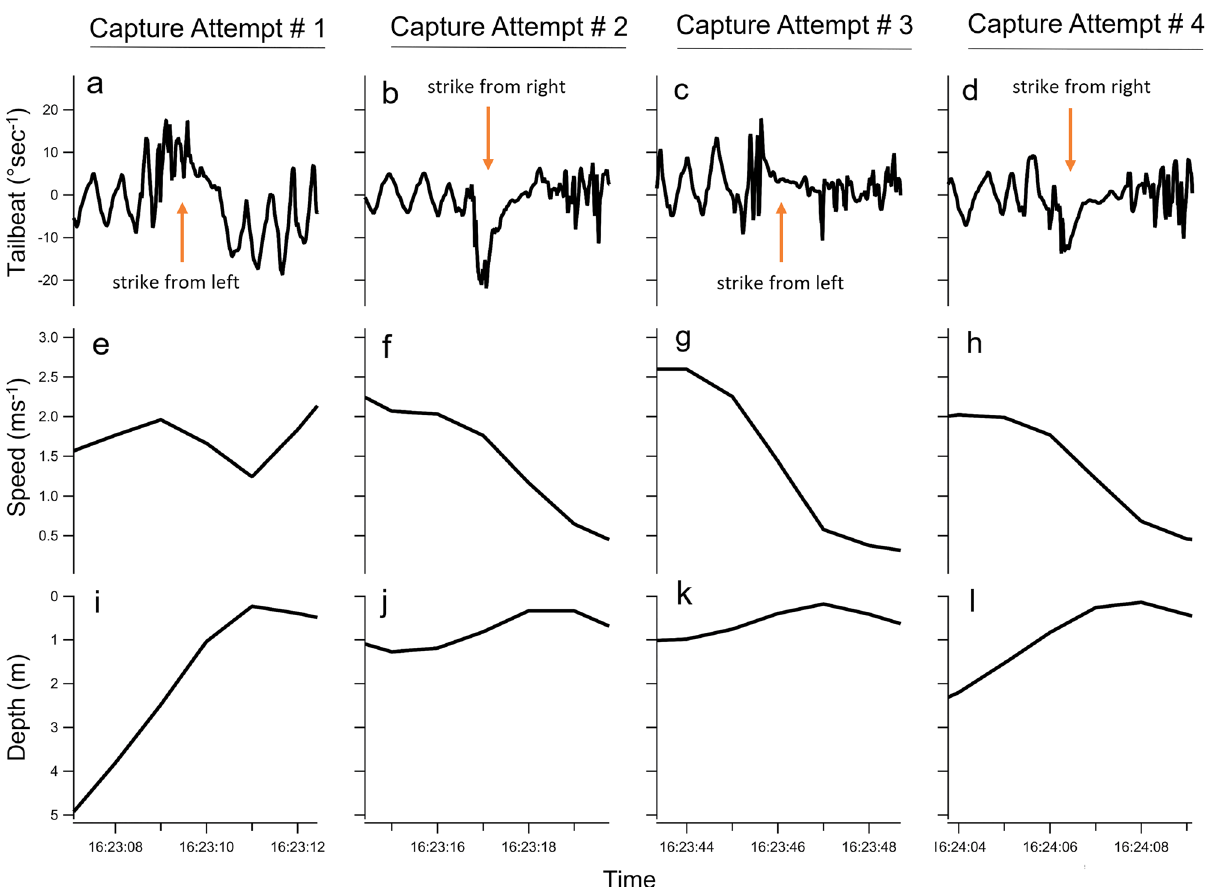
Figure 4. Zoomed in portions (4 s) of the tailbeat (°rotation s −1 ), speed (ms −1 ) and depth (m) of the four different capture attempts ( a – d , respectively) during the one-on-one pursuit (see supplemental